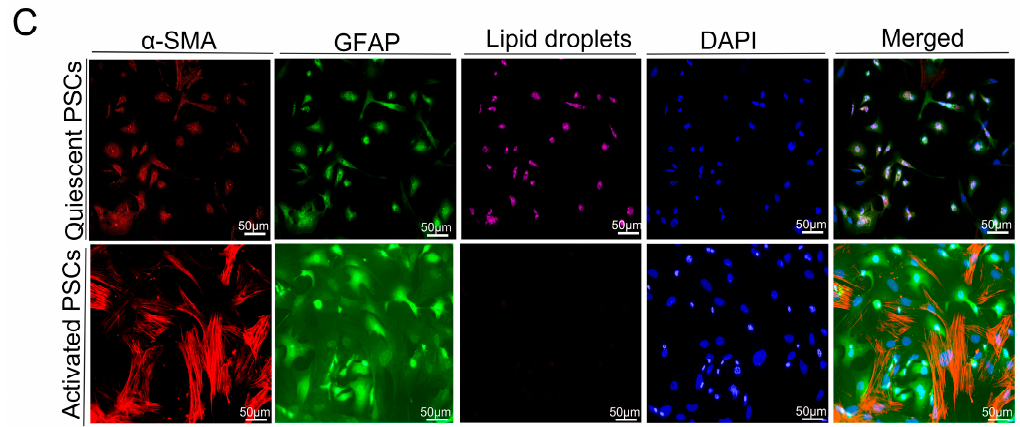
Figure 5. Macrophages promoted the activation of PSCs. ( A ) PSCs in co-cultured group were more active than those in the control group; ( B ) Western-blot analysis verified that the expression of α -smooth muscle actin ( α -SMA) in PSCs was significantly higher than that in the control group; in addition, glial fibrillary acidic protein (GFAP) did not change significantly, and β -actin was used as a reference; ( C ) An immunofluorescence assay confirmed that the main changes in PSCs were ascribed to the disappearance of lipid droplets and the increased expression of α -SMA.